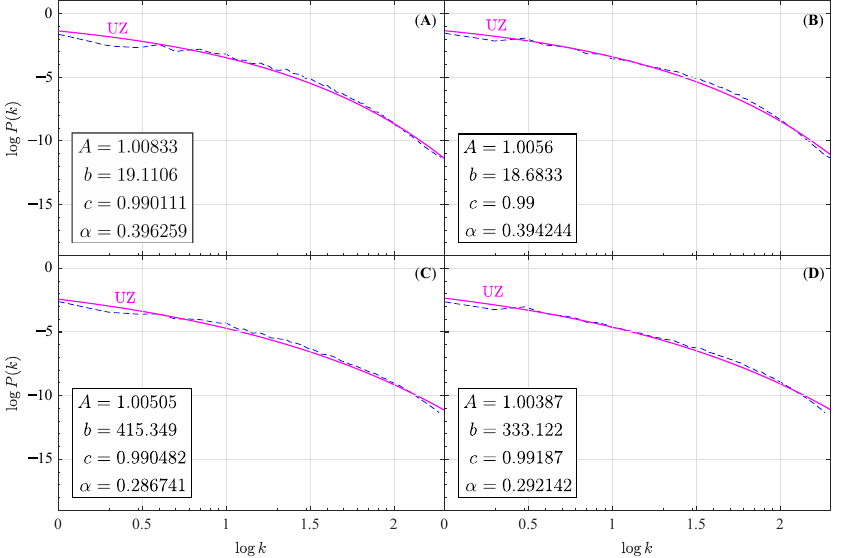
Figure 5. Power spectra approximations of ISM data. The blue dashed lines are simulated power spectra from [33]: ( A ) is the energy spectrum generated MHD simulation with a lower Alfvénic-Mach number and the thick case of varying abundances; ( B ) is the same with a greater Alfvénic-Mach number and the thick case of varying abundances; ( C ) is the same with a lower Alfvénic-Mach number and the normal case of varying abundances; ( D ) is the same with a greater Alfvénic-Mach number and the normal case of varying abundances. The purple lines are the Uchaikin–Zolotarev (UZ) spectrum approximated by function (2). The values of A , b , c , and α in the corners are the parameters for the UZ-spectrum (2). Adapted with permissions from Ref. [33]. Copyright